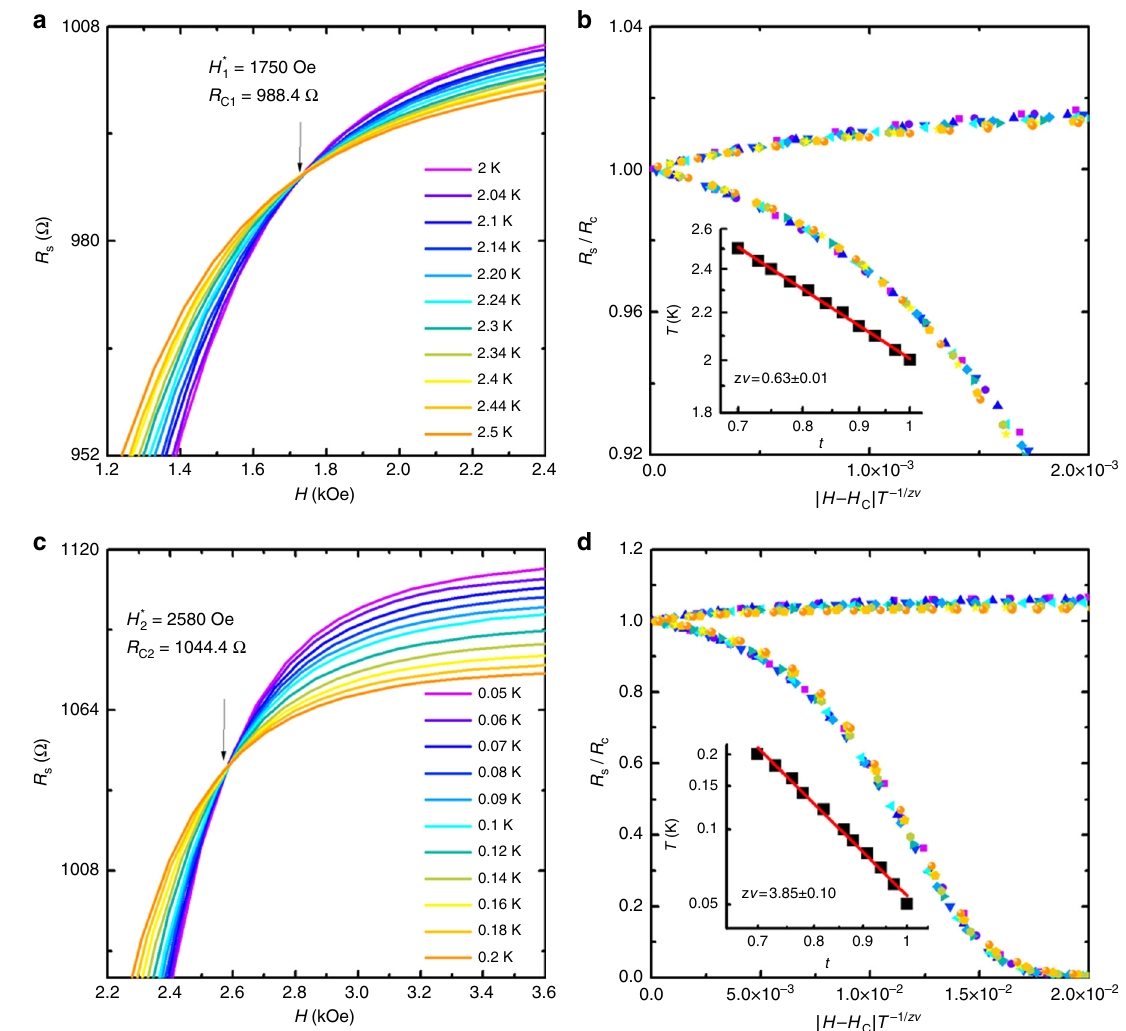
Fig. 4 Scaling behavior of the superconductor-insulator quantum phase transition in graphene – tin nanoislands array. a Sheet resistance R s as a function of magnetic fi eld H for different temperatures from 2 to 2.5 K. The black arrow indicates the critical magnetic fi eld and the critical sheet resistance. b Finite- size scaling analysis of QPT by utilizing the same data extracted from a . Inset: the temperature as a function of the scaling parameter t ( T ) on a log-log scale (see the main text for de fi nition of t ). The power-law fi tting determines zv = 0.63 ± 0.01. c Sheet resistance R s as a function of magnetic fi eld H for different temperatures from 0.05 to 0.2 K. d Finite-size scaling analysis of QPT utilizing the same data extracted from c . Inset: the temperature as a function of the scaling parameter t on a log-log scale. The power-law fi tting determines zv = 3.85